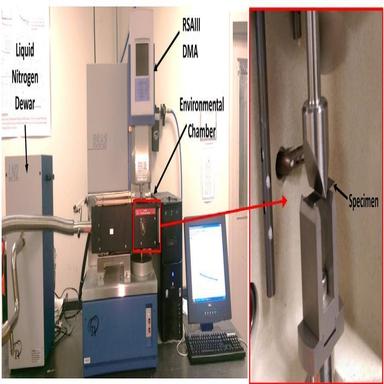
Dynamic mechanical analyzer setup. Inset: Closeup view of the three-point bend fixture and specimen inside environmental chamber.